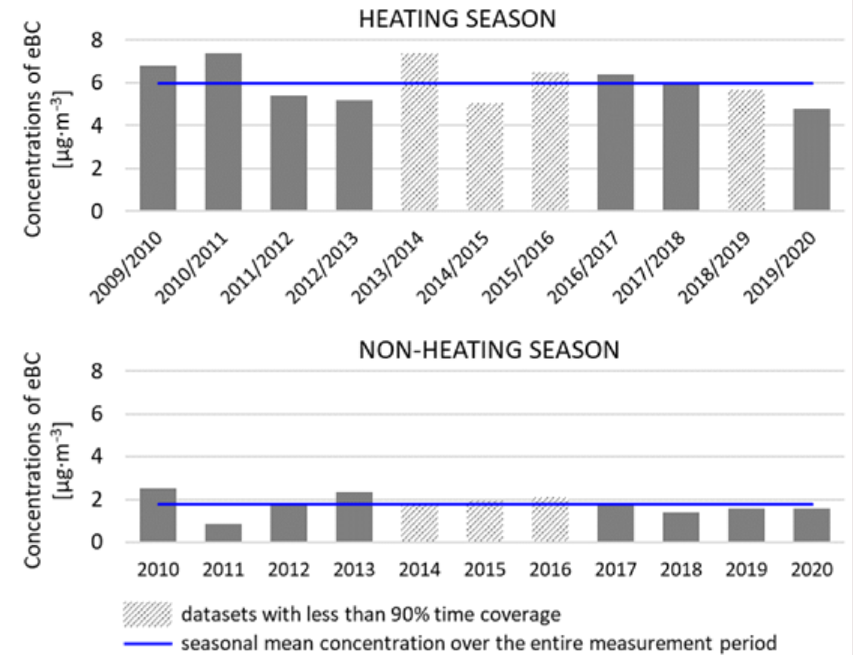
Figure 6. Seasonal course of eBC concentrations ( µ g · m − 3 ) recorded for the heating and non- heating season. Table 2. Descriptive statistics of the series of eBC concentration divided into non-heating and heating seasons. Period Time Coverage